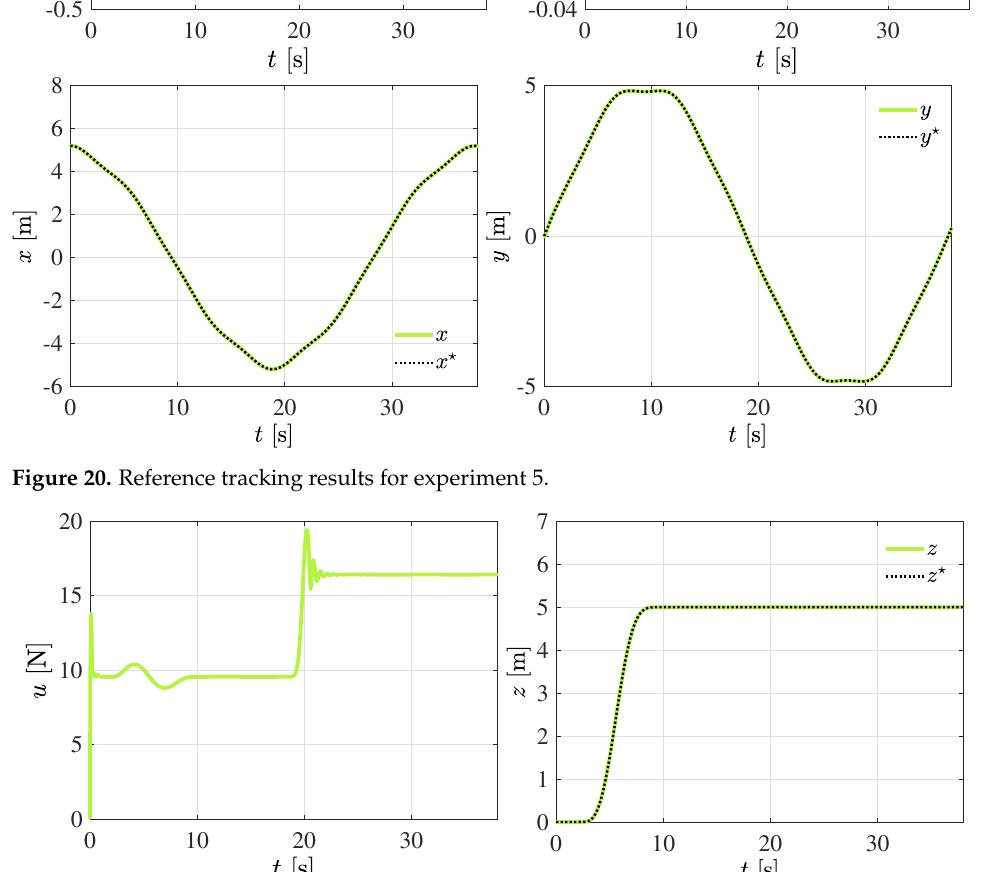
Figure 21. Simulation results for experiment 5. ( a ) Main force control input. ( b ) Controlled verti- cal